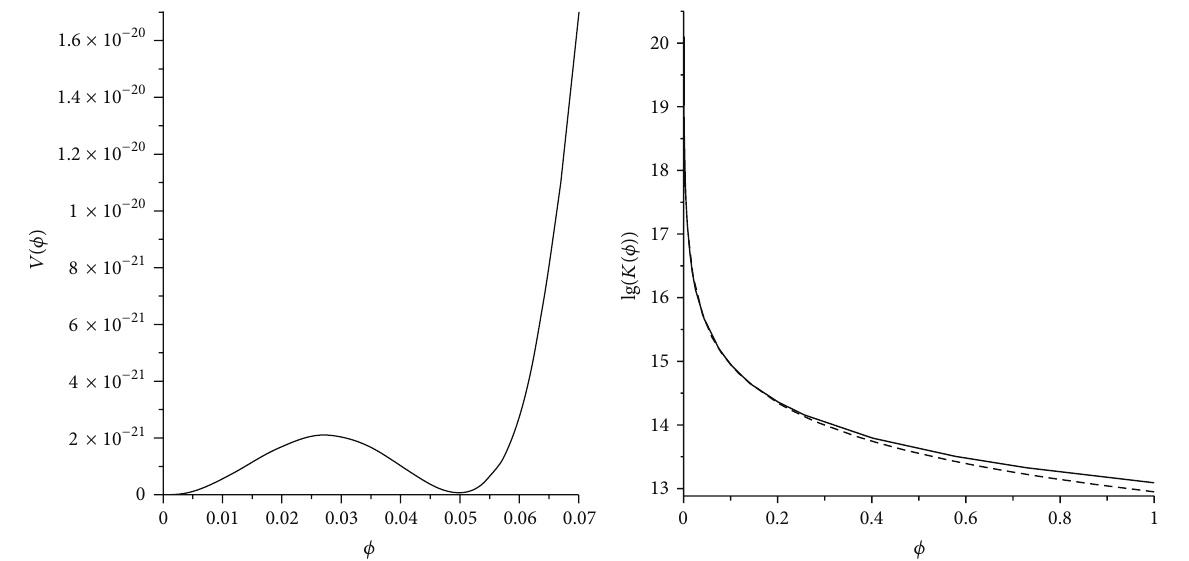
Figure 1: Right panel: Solid line: lg 𝐾(𝜙) function; dotted line: approximation of lg 𝐾(𝜙) ; see (15). One can see that this approximation is valid for the small values of 𝜙 where a dynamic is developed; see Left panel: Potential 𝑉(𝜙) . Numerical values of the parameters are listed in the caption of Figure 3.